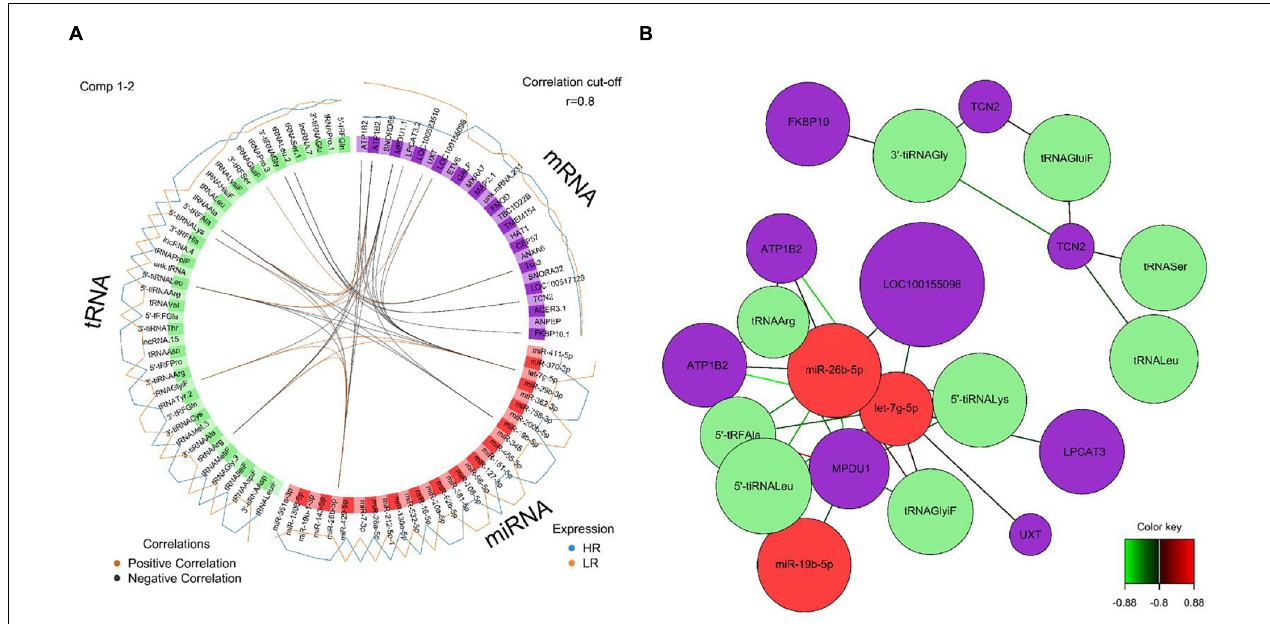
FIGURE 6 | (A) Circos plot of mRNA, miRNA, and tRNA linked to coping behavior haplotype groups in the adrenal gland. Positive correlations are indicated by brown-colored connectors, while black connectors indicate negative correlation between mRNA, miRNA and tRNA. Blue and orange colored lines in the outer circle highlight expression levels in either high (HR) or low (LR) reactive coping group. (B) Network visualization of mRNA, miRNA, and tRNA panels indicating correlated variables in the adrenal gland ( r > | 0.80|). Purple colored nodes represent mRNA, red nodes indicate miRNA and green nodes highlight tRNA biomarkers. Correlation between nodes is indicated by edge color as shown in the color key. Negative correlation is depicted by green edges, while red edges represent positive correlation.